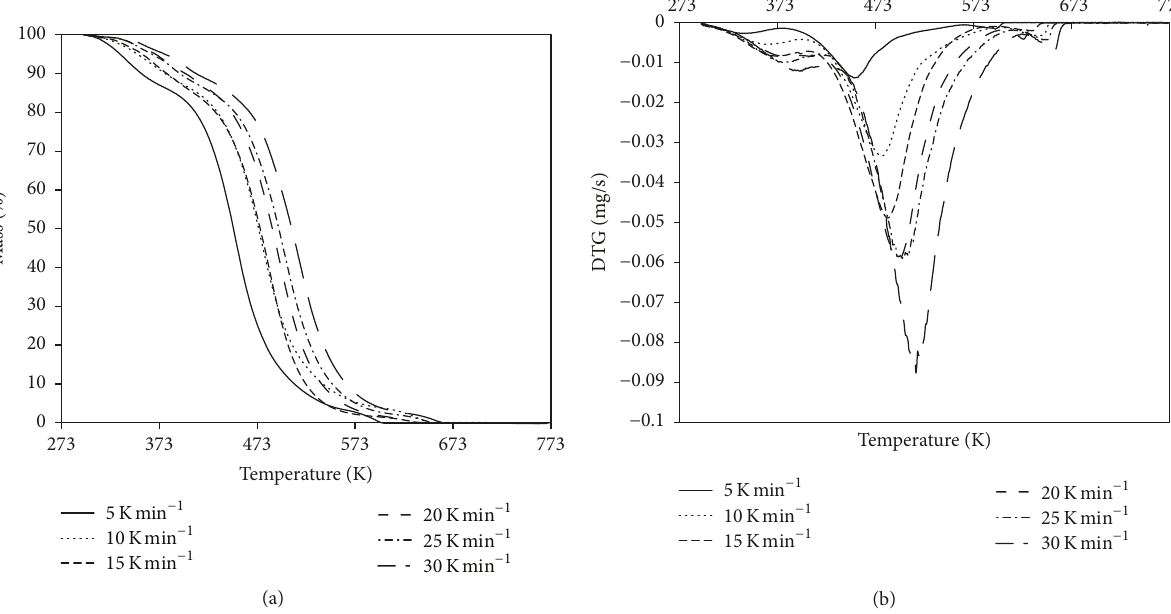
Table 1: Evaporation kinetic parameters of lactic acid by Arrhenius and Kissinger